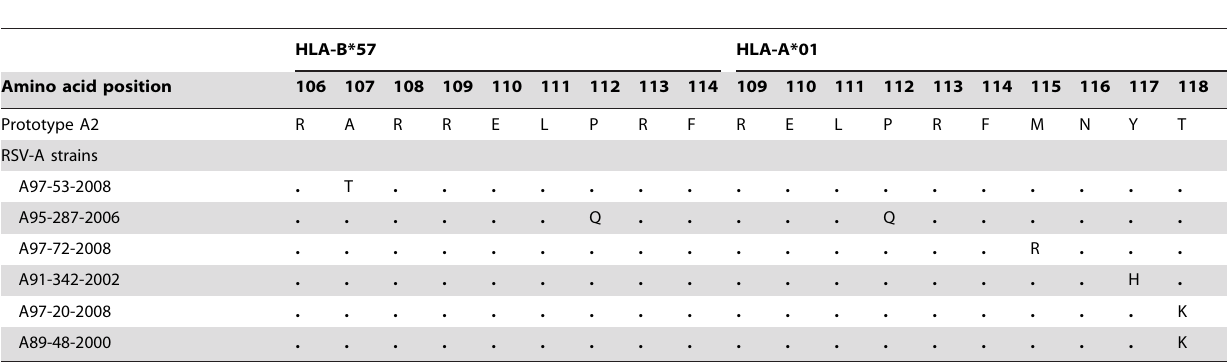
Table 2. Difference of amino acid in CTL-specific epitopes (HLA-B57, HLA-A*01) between RSV prototype (A2) and Taiwan RSV-A strains.